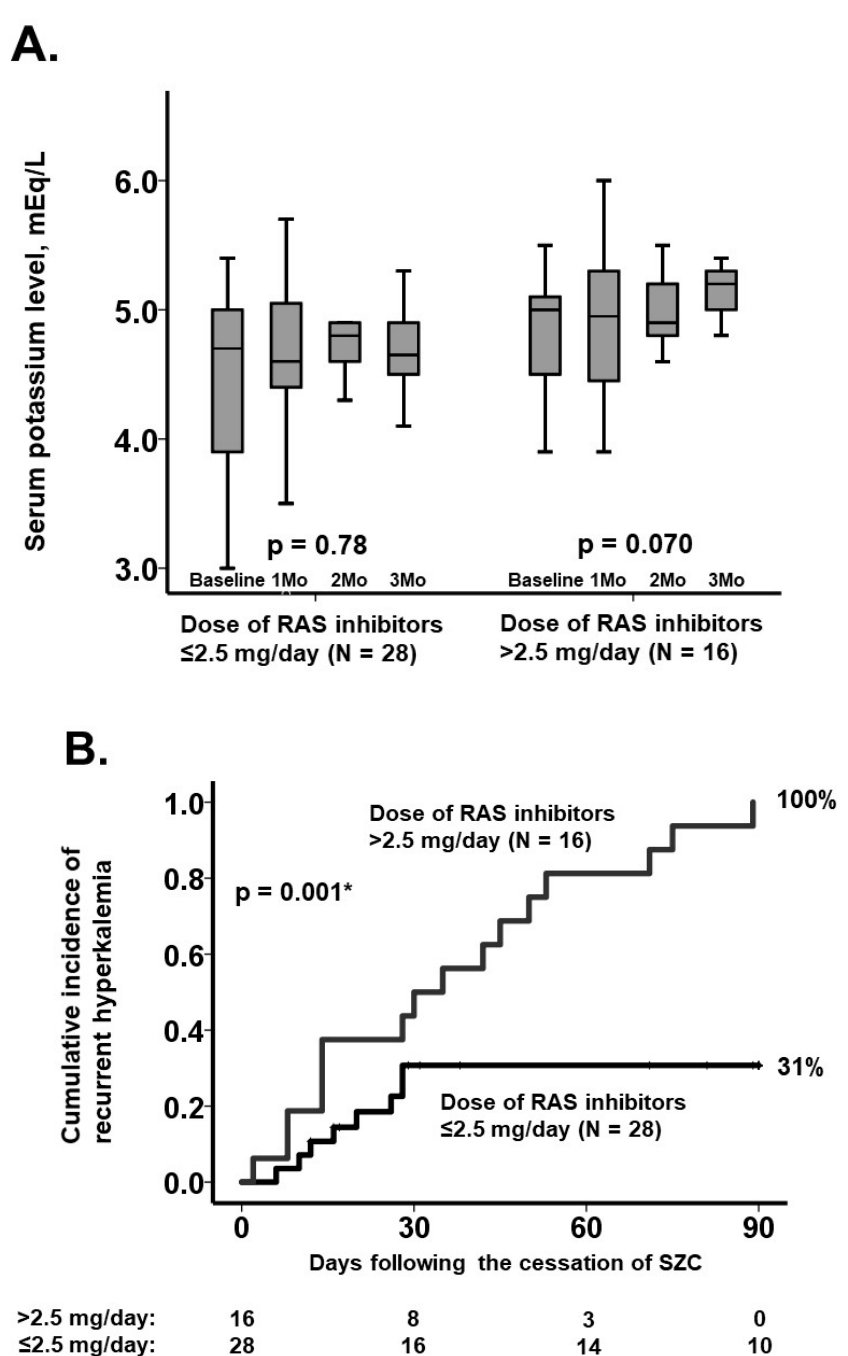
Figure 2. Three-month trends of serum potassium levels following SZC cessation ( A ) and cumulative incidence of recurrent hyperkalemia ( B ) stratified by the cutoff of baseline dose of RAS inhibitors. Trends were assessed by using the Friedman test, and cumulative incidences were compared by using the log-rank test. * p < 0.05.